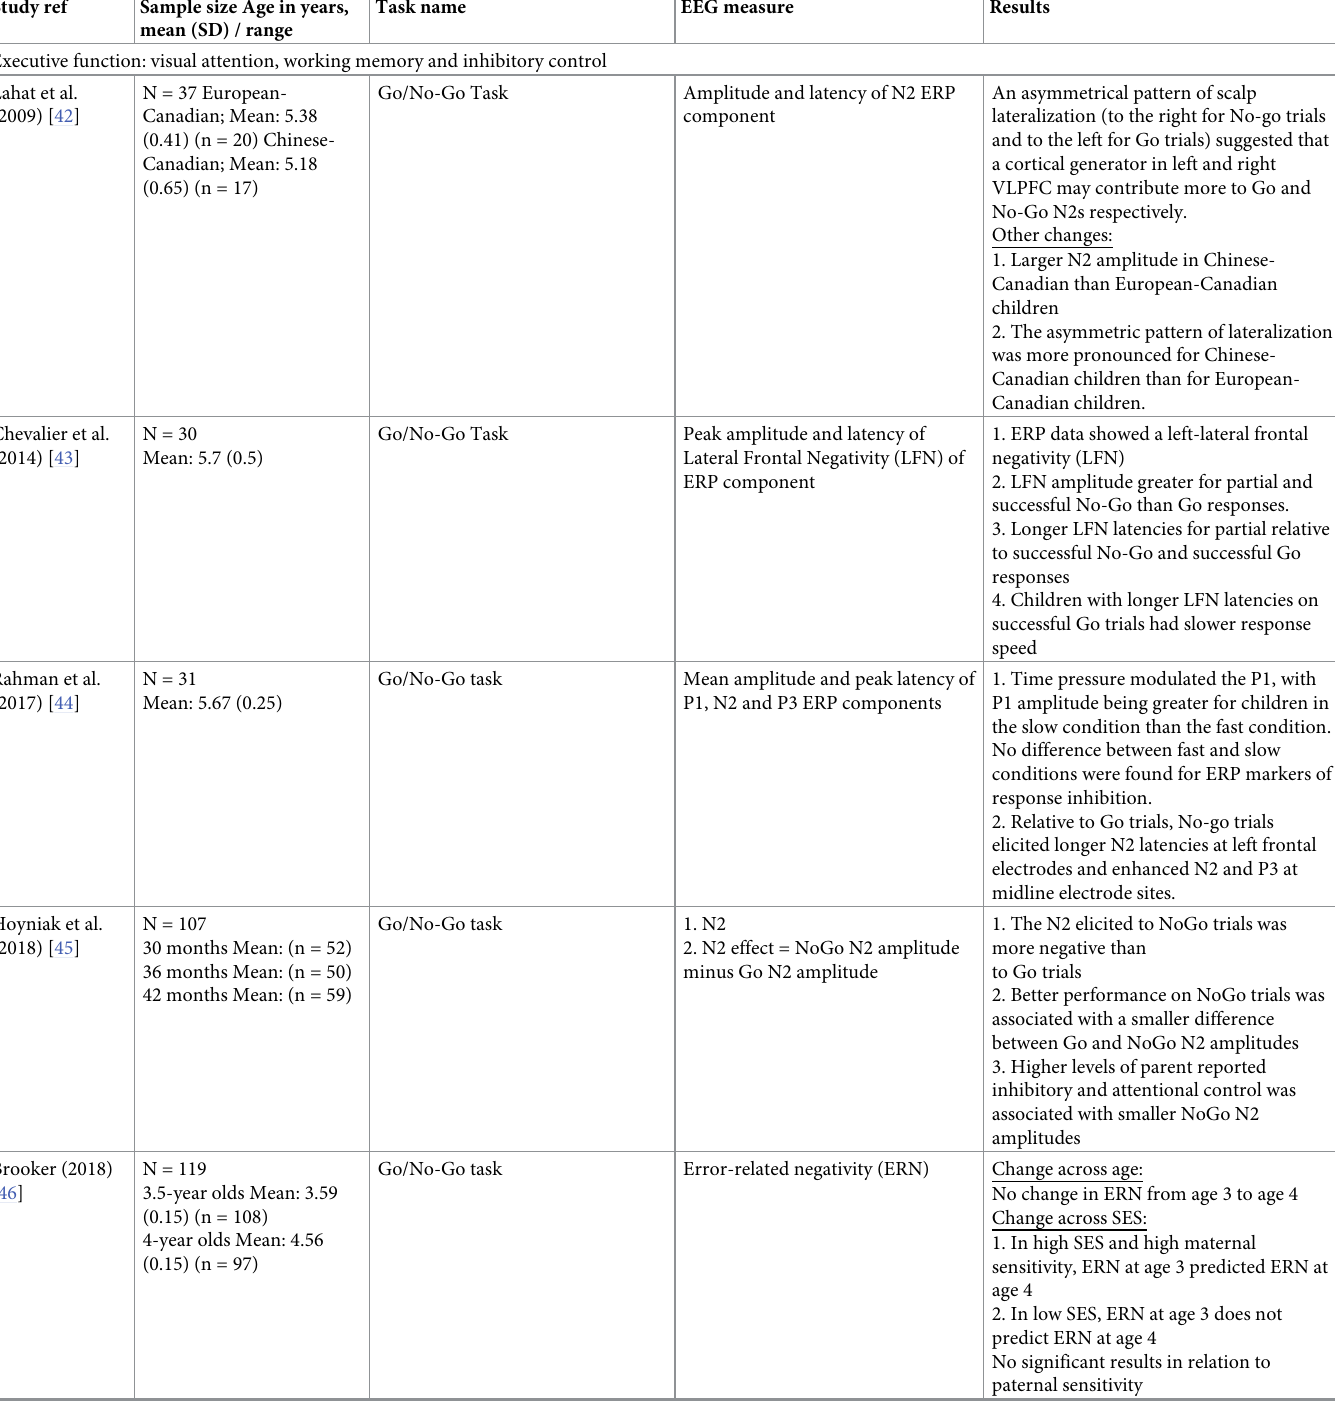
Table 1. Details of included papers: Sample size, mean age, task name, EEG metric and results in relation to the cognitive ability, age, gender and socioeconomic